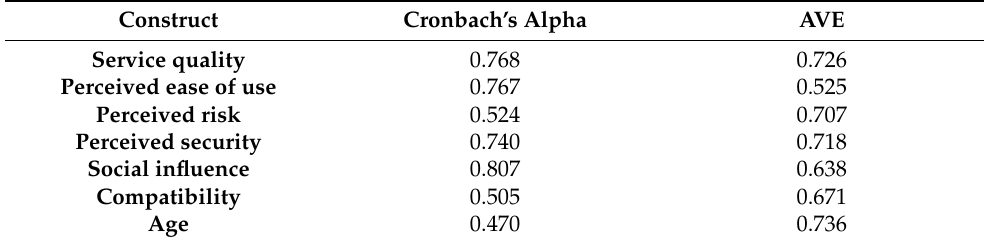
Table 8. Results of the Cronbach’s alpha and